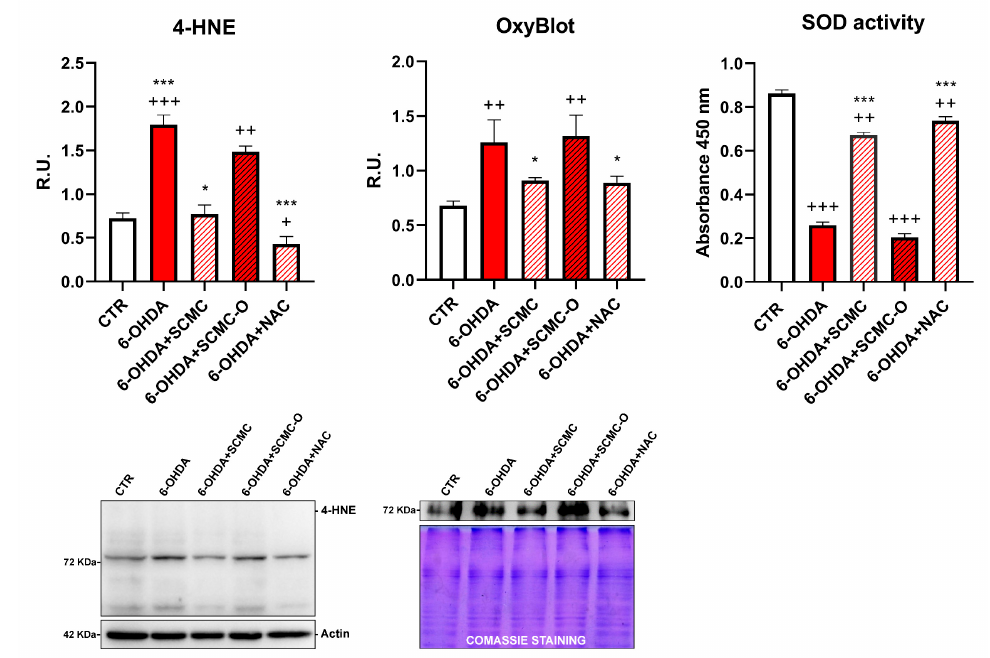
Figure 4. 4-HNE, OxyBlot assay, and SOD activity analyses are shown. Data are mean ± SD of three different experiments. *: p < 0.05; ***: p < 0.0001 vs. 6-OHDA; +: p < 0.05; ++: p < 0.005; +++: p < 0.0001 vs. CTR. A representative figure for 4-HNE and Oxyblot are reported.